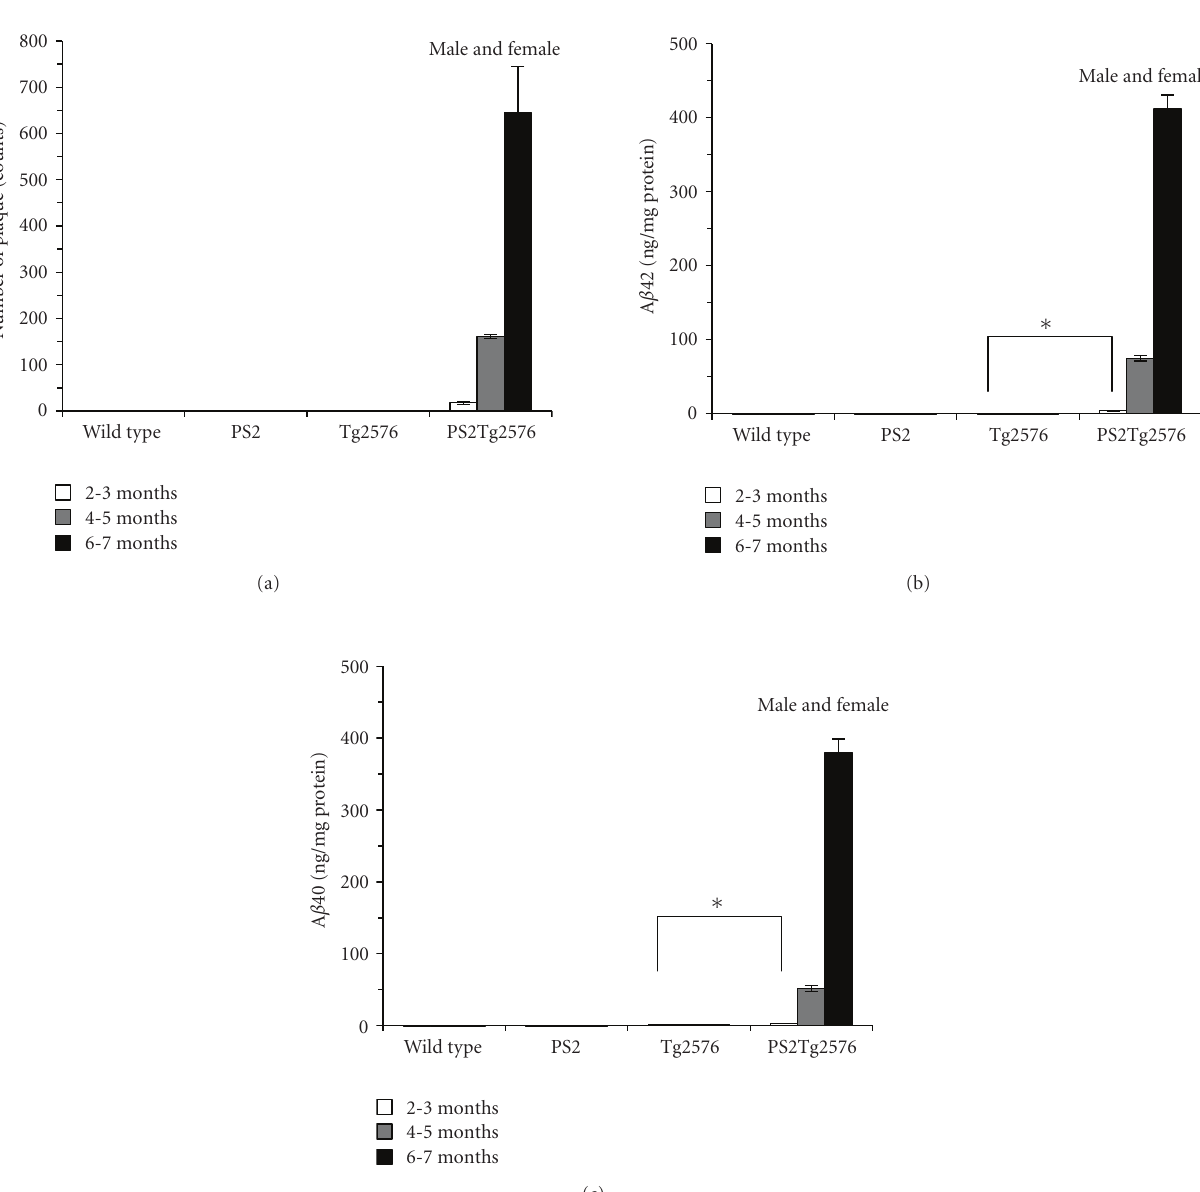
Figure 2: Quantification of cerebral amyloid accumulation in PS2Tg2576 mice. (a) Number of amyloid plaques (counts per cross section of half brain ± s.e.m) according to 82E1 antibody staining ( n = 3). ELISA measurement of A β 42 (b) and A β 40 (c) in the TBS-insoluble fraction prepared from whole mouse brains ( n = 3–8). The values are expressed as mean ± s.e.m ng per mg of protein. Statistical significance was assessed using the unpaired T -test and Welch’s test: ∗ P < . 05 compared with the Tg2576 mice at 2-3 months of age. No other di ff erences were